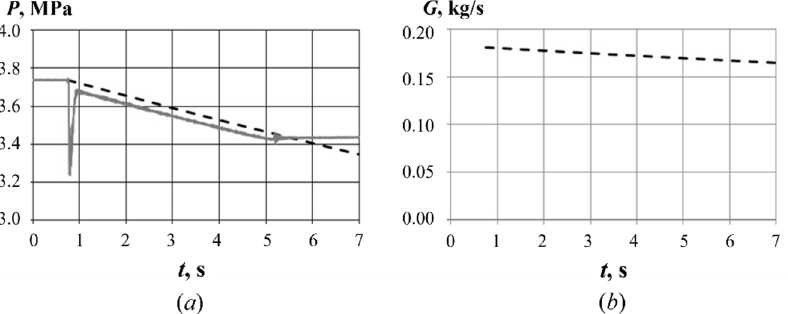
Figure 6. Example of determining the air mass flow rate G in ( t ) in one of test fires (test fire #4, see below): ( a ) time history of pressure in the air storage vessel (solid curve) and its approximation (dashed curve) according to Equation (1), and ( b ) time history of the air mass flow rate according to Equation (2).